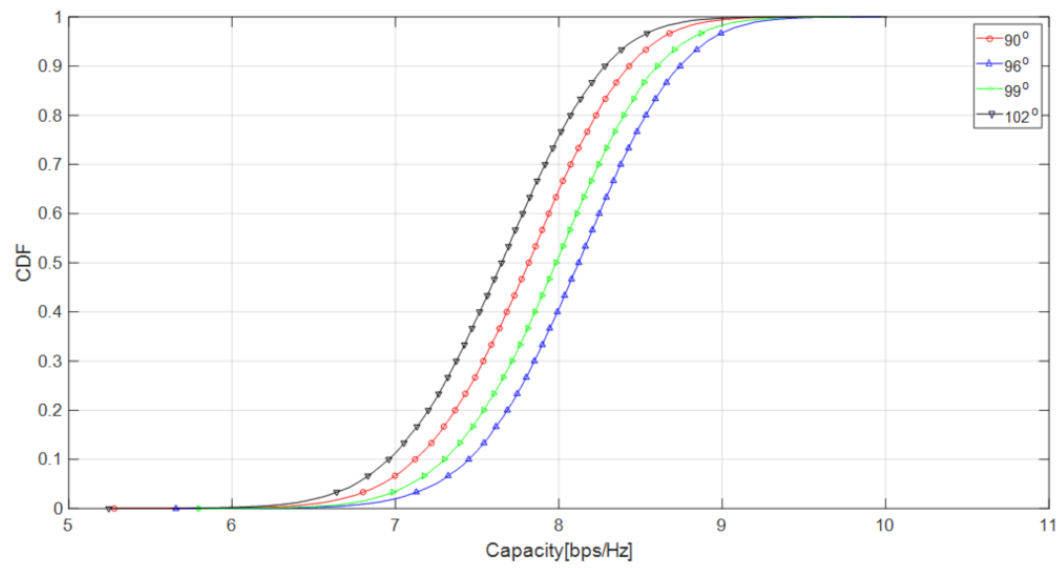
Figure 5. CDF of channel capacity for θ tilt = 90 ◦ , 96 ◦ , 99 ◦ , and 102 ◦